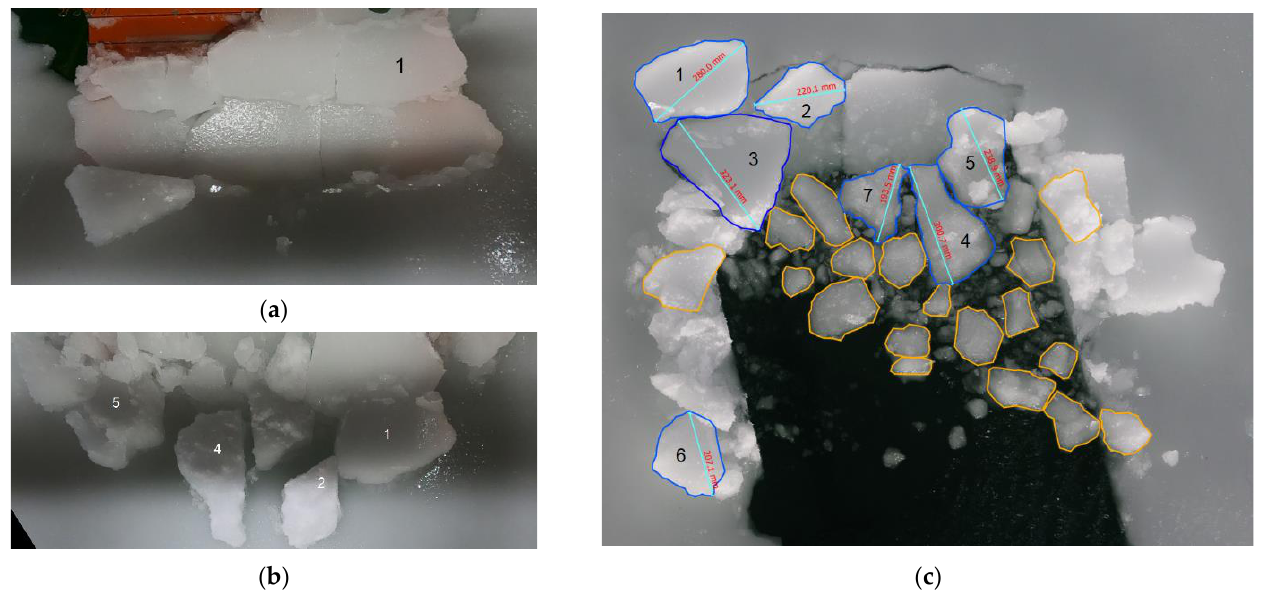
Figure 10. “Plane 3” test: ( a ) broken ice blocks when the structure moved in the channel, showing the orthorectified scene on the slope of the structure in the video frame at 02:16; ( b ) broken blocks ejected away or slipped down the rubble pile, showing the orthorectified scene on the ice sheet surface in the video frame at 04:28; ( c ) after-test nadir drone view of the polynya.